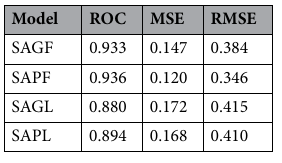
Table 4. ROC, RMSE, and MSE values for each